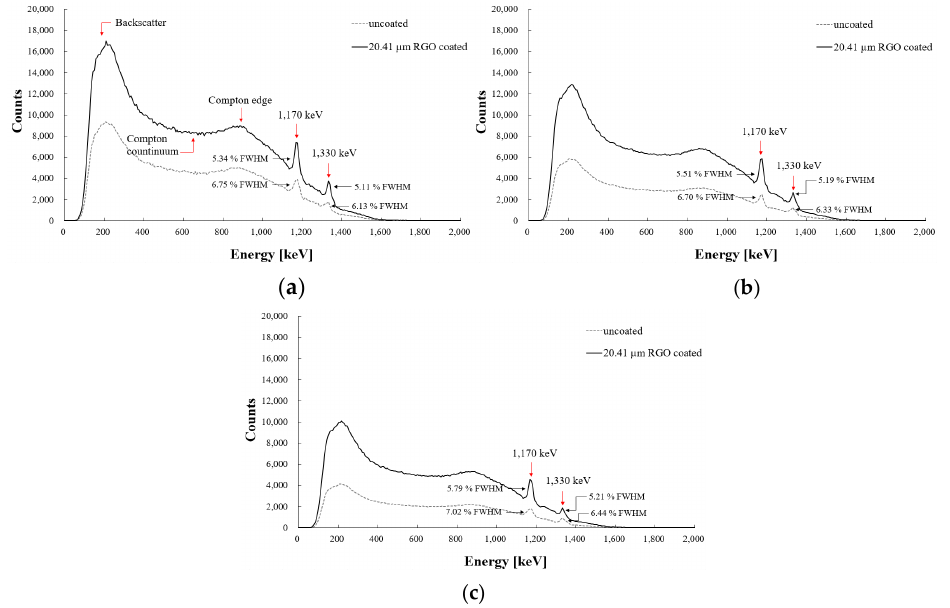
Figure 6. Gamma-ray energy spectra of the 60 Co radioisotope for three types of inorganic scintillators ( a ) GAGG:Ce, ( b ) LYSO:Ce, and ( c ) CdWO 4 . Table 2. Improvement in total amount of scintillating light increments and FWHMs reductions in energy spectra of the 60 Co source according to inorganic scintillators.